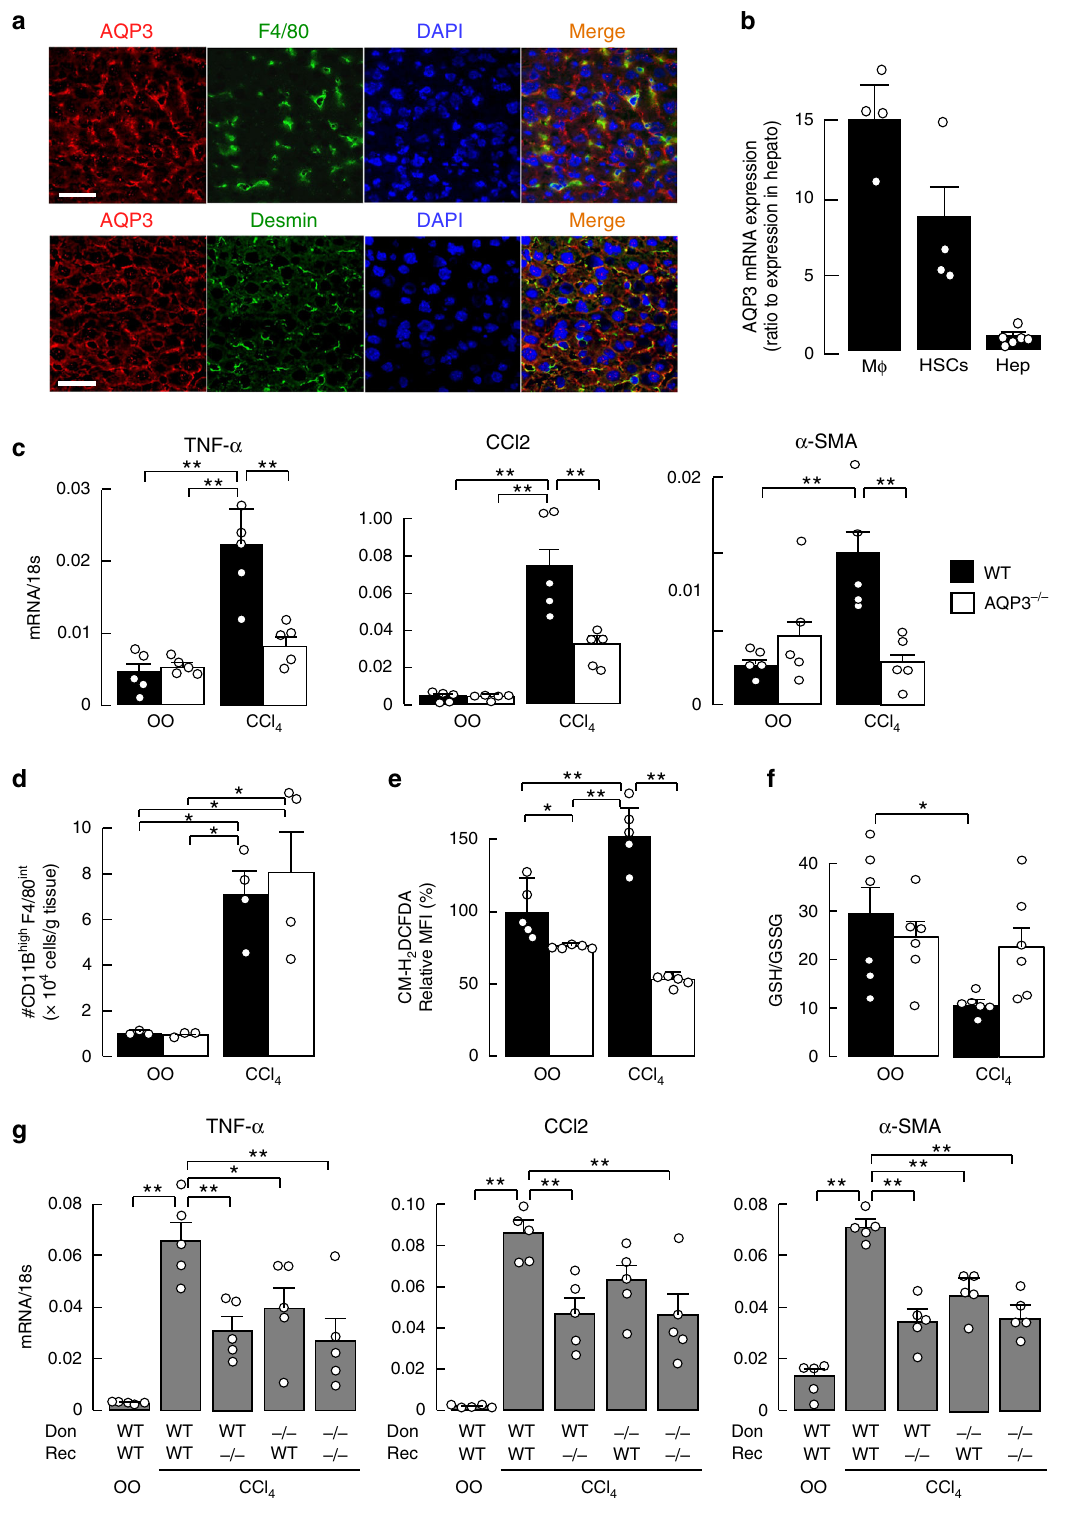
(Fig. 2e), supporting the requirement of AQP3 in macrophages for CCl 4 -induced liver